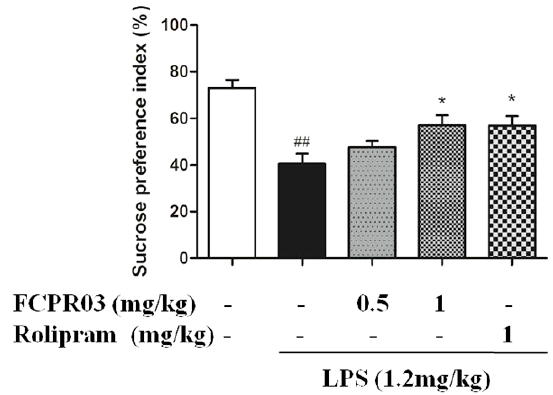
Figure 4. FCPR03 increased sucrose preference in mice challenged with LPS during sucrose intake test. After seven consecutive days of pretreatment with FCPR03 (0.5 mg/kg or 1 mg/kg) or rolipram (1 mg/kg), mice were injected i.p. with saline or LPS (1.2 mg/kg, i.p.); 24 h after LPS injection, the preference to sucrose solution were measured. Data are expressed as the mean ± SEM. ## p < 0.01 compared with control group; * p < 0.05 compared with LPS group ( n = 8 per